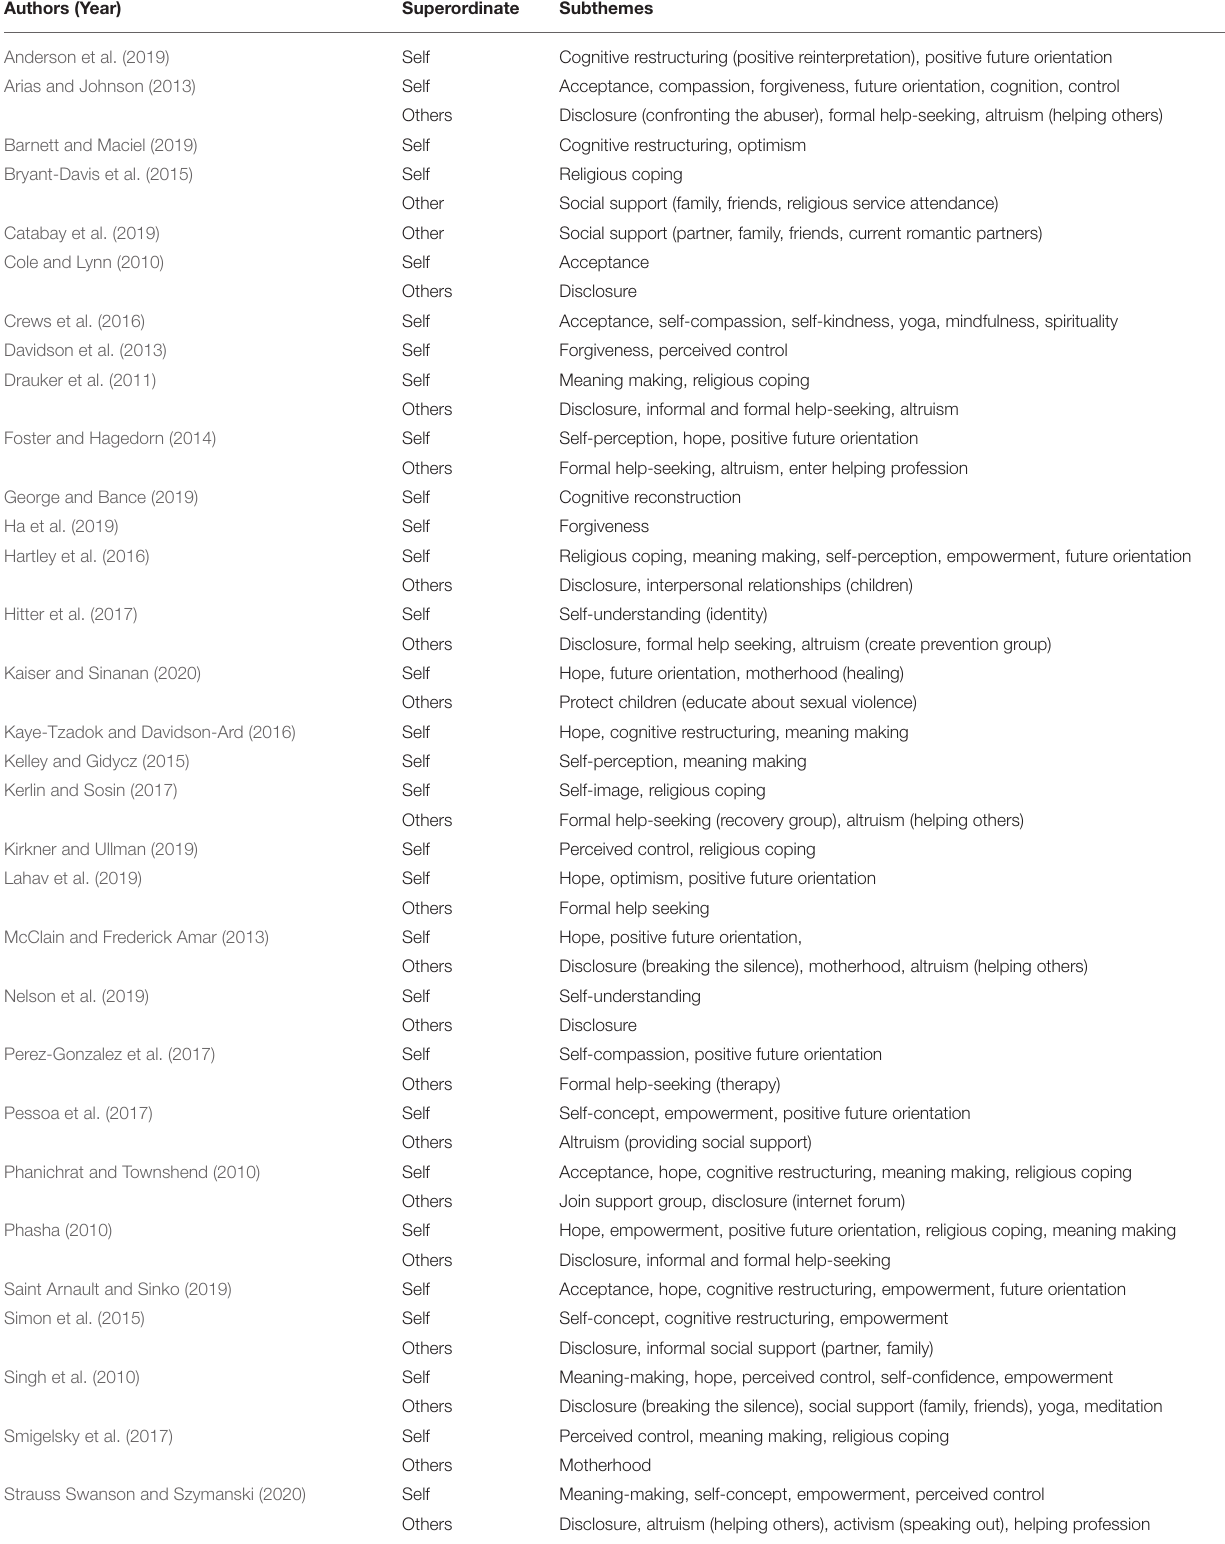
TABLE 2 | Superordinate and sub